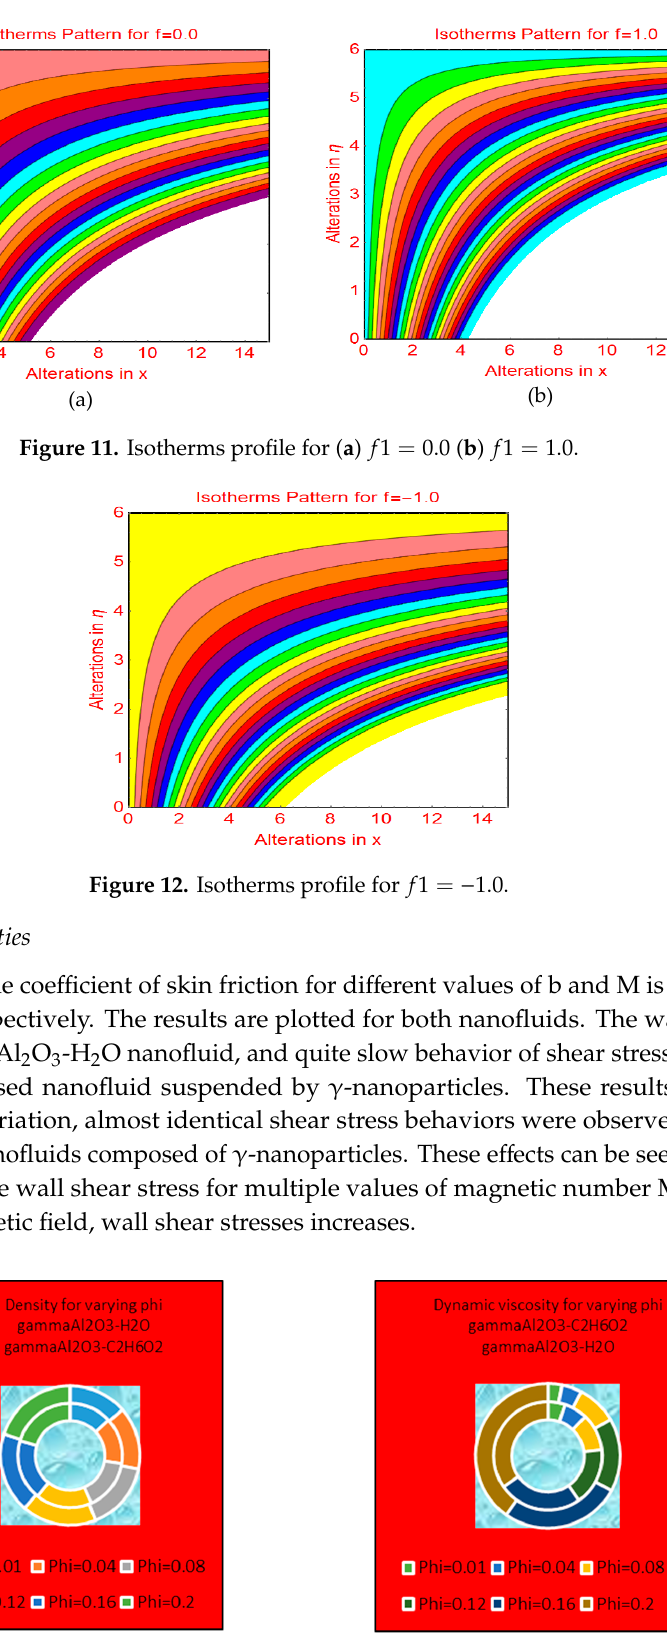
. Figure 14. Effects of 𝜙 on effective thermal conductivity 4.5. Engineering Quantities The behavior of the coefficient of skin friction for different values of b and M is demonstrated in Figures 15 and 16, respectively. The results are plotted for both nanofluids. The wall shear stresses increase abruptly for γ Al 2 O 3 -H 2 O nanofluid, and quite slow behavior of shear stresses is determined for ethylene glycol-based nanofluid suspended by γ -nanoparticles. These results are pictured in Figure 15. Through variation, almost identical shear stress behaviors were observed for both water and ethylene glycol nanofluids composed of γ -nanoparticles. These effects can be seen from Figure 15.